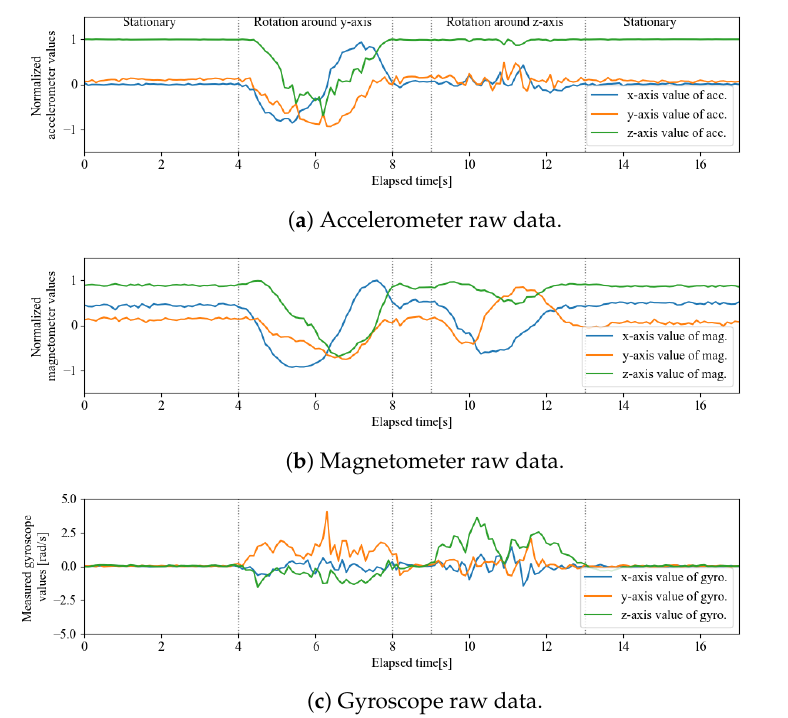
( c ) Gyroscope raw data. Figure 11. Experimental data obtained from actual equipment